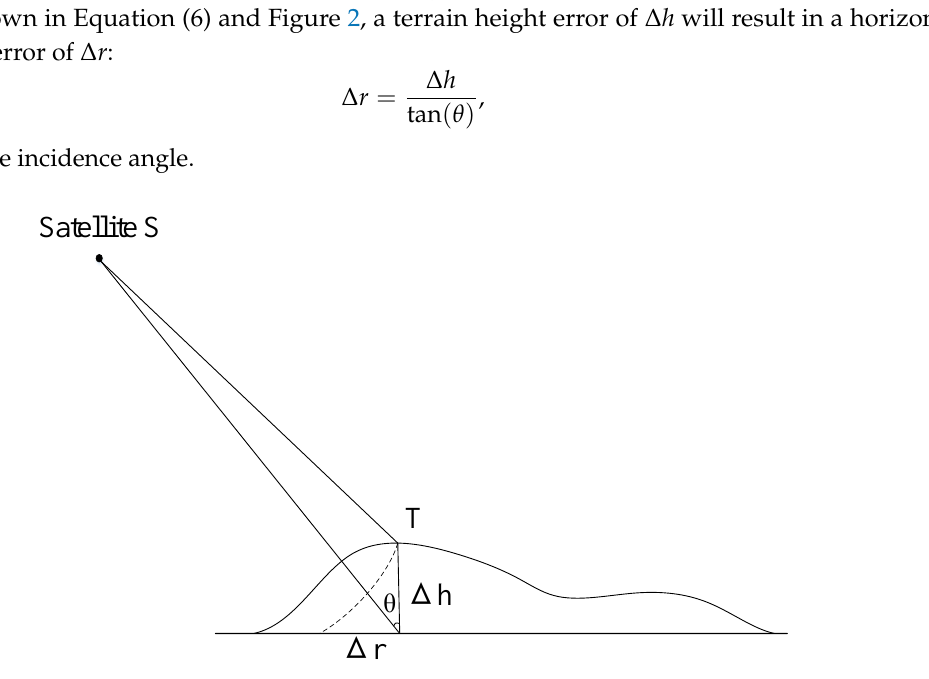
Figure 2. Positioning error caused by terrain height error.